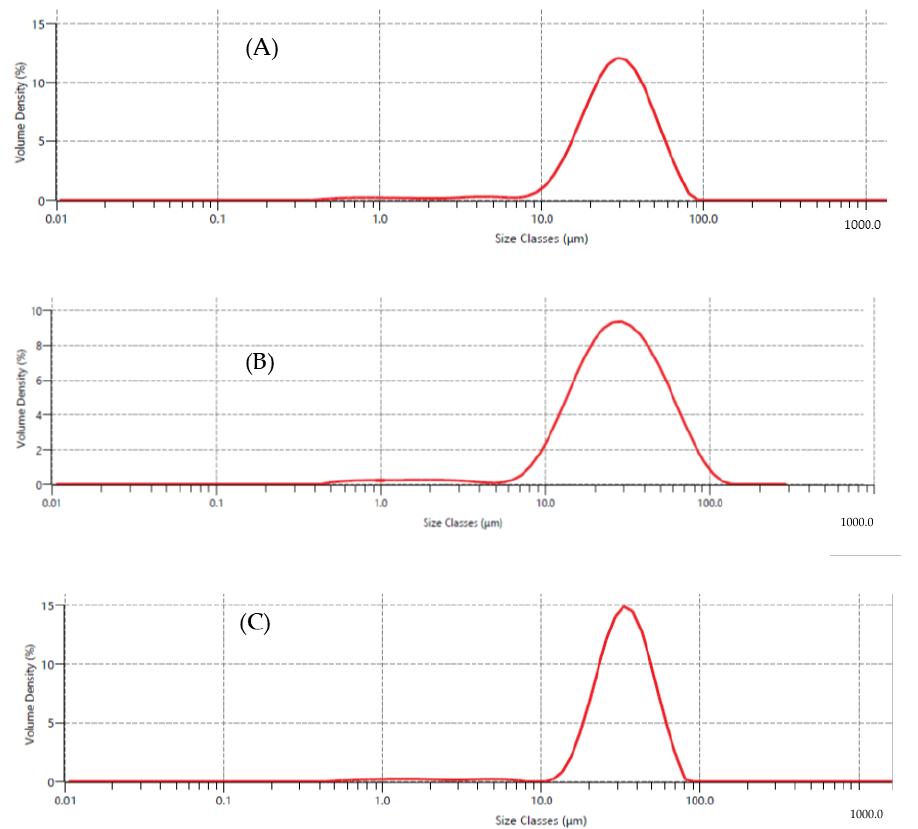
Figure 6. Particle size distribution of microcapsules. ( A ) GAM, gum arabic microcapsule (CSP extract coated with GA), ( B ) MDM, maltodextrin microcapsule (CSP extract coated with MD), and ( C ) GMM, gum arabic + maltodextrin microcapsule (CSP extract coated with the mixture of GA +